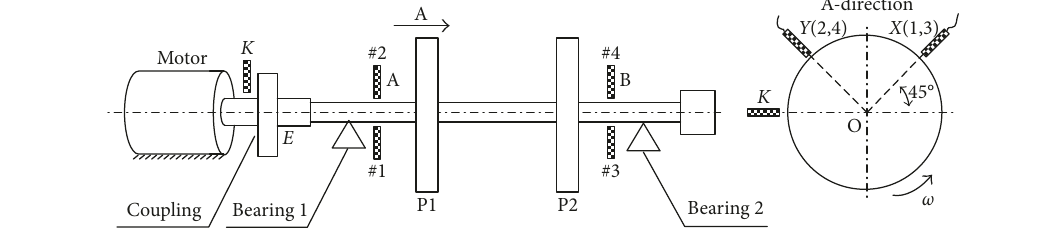
Figure 2: The structure of the test rig.